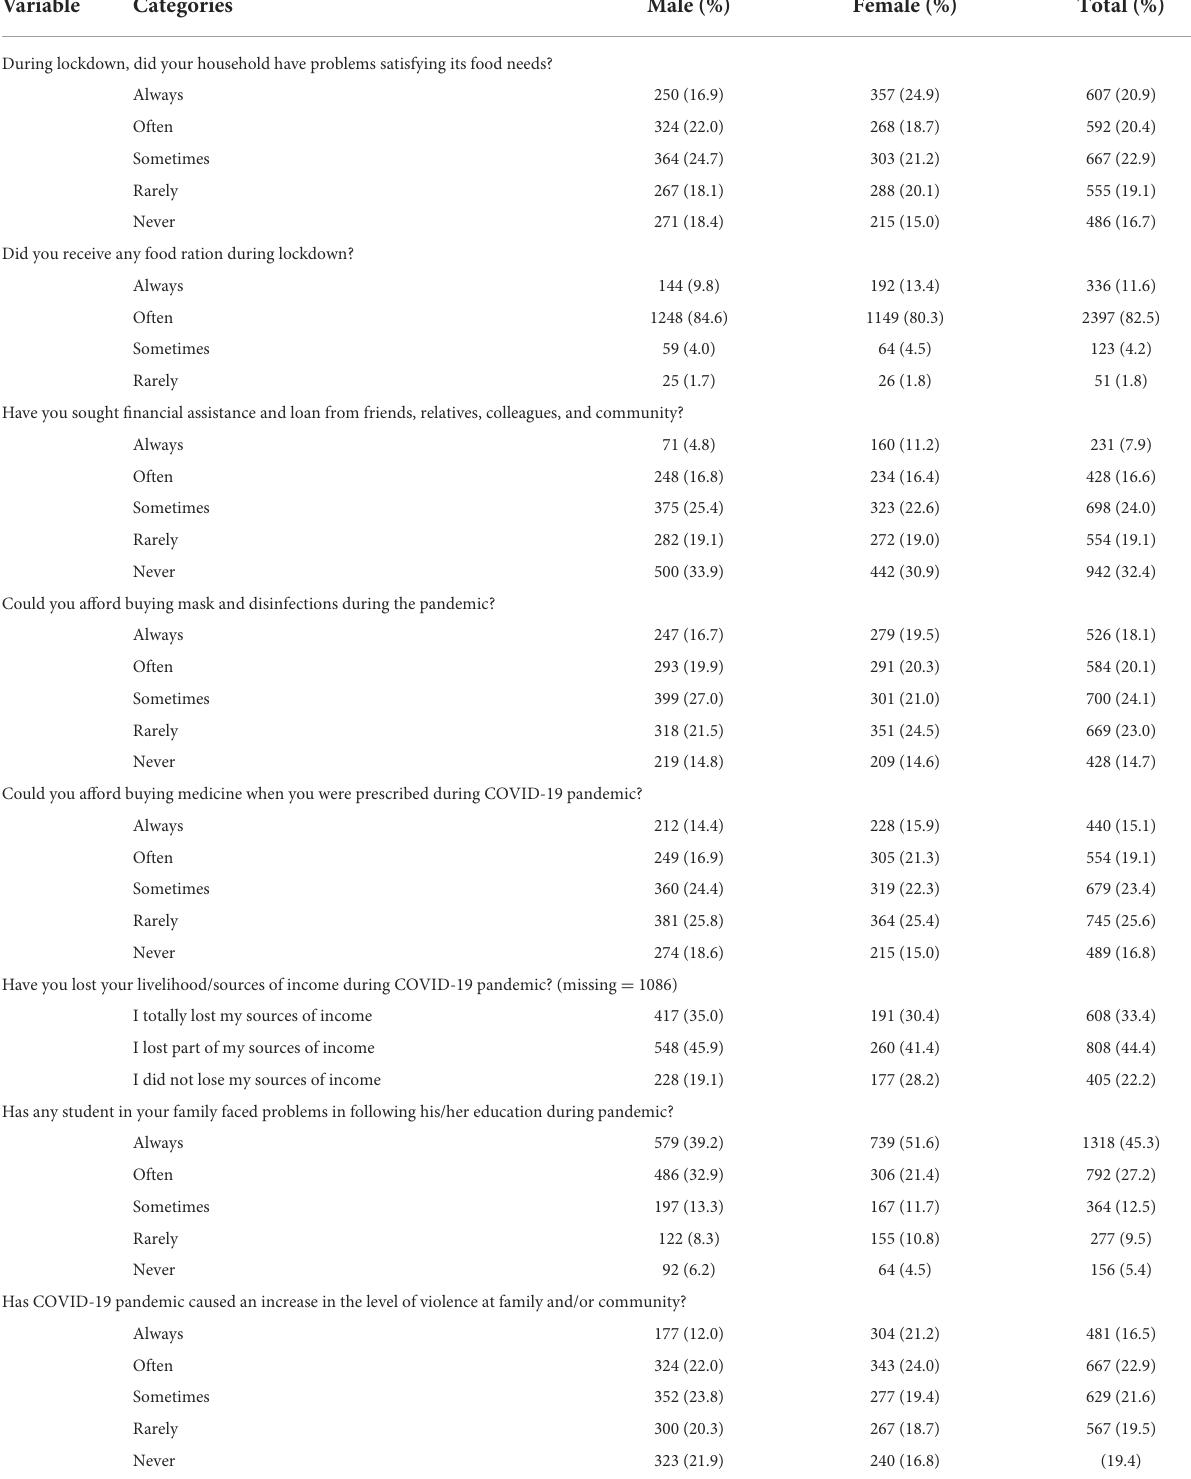
TABLE 8 Frequency distribution on socio-economic Impact of COVID-19 pandemic ( N = 2907).